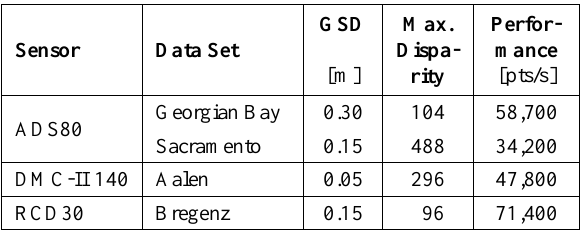
Table 2: SGM processing job statistics for different sensors and data